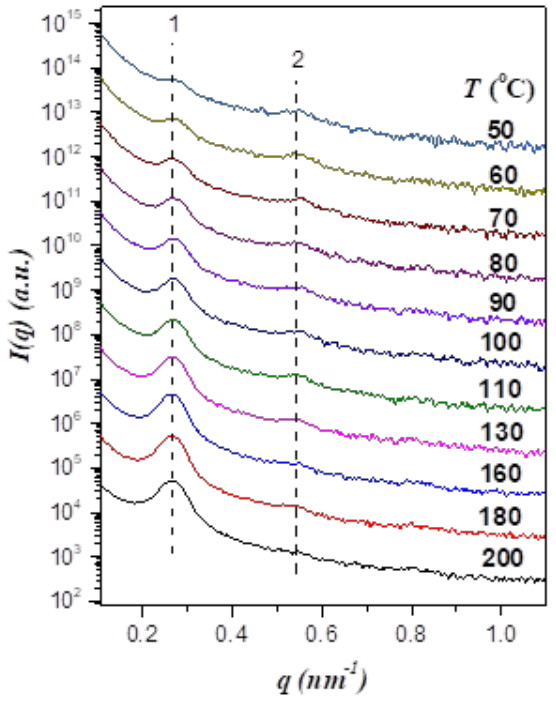
Figure 1. Temperature-dependent SAXS profiles of neat EO4VP collected in a cooling cycle. The scattering curves are shifted vertically for the clarity of presentation. The SAXS profiles demonstrate the formation of lamellar morphology over the temperature range studied. The primary peak diminished and broadened progressively with decreasing